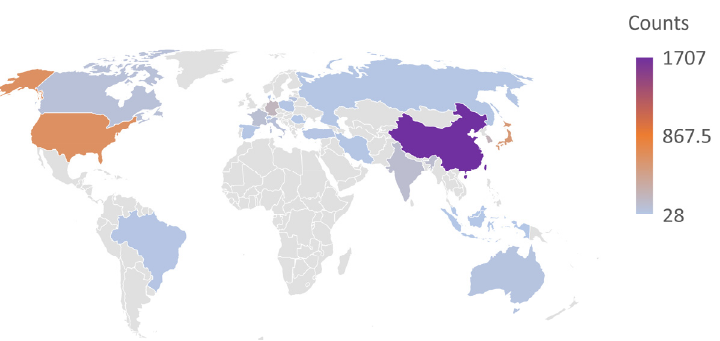
Figure 1. Published map of linear ultrasonic motors collected from Web of Science Core Collection ® date to 12 August 2022 (search item: ”linear ultrasonic motors” or ”linear piezoelectric motors”).